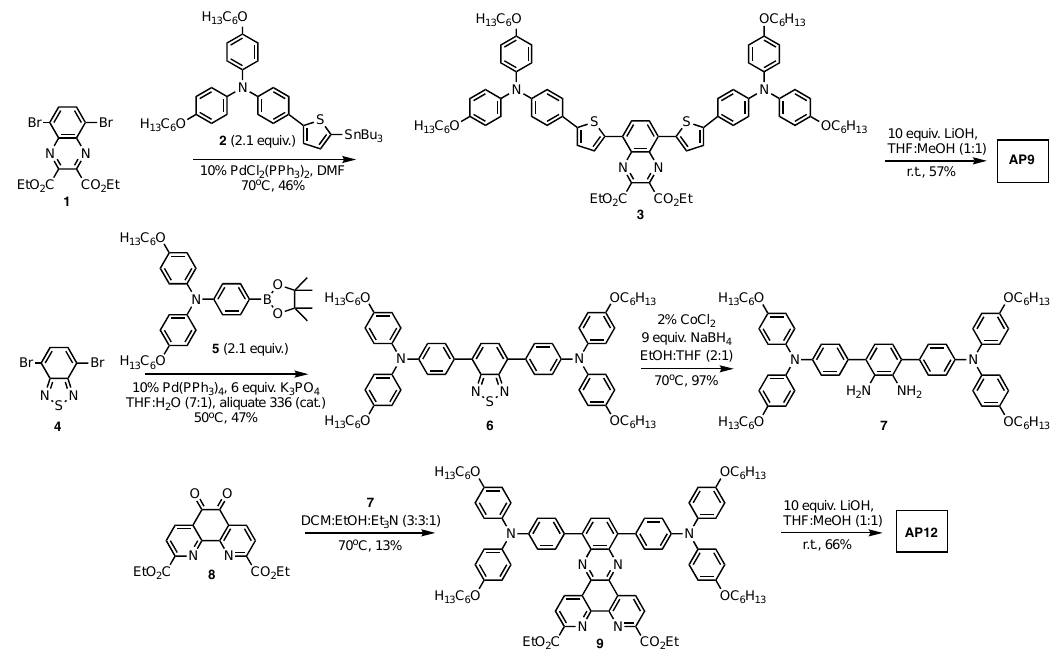
Scheme 1. Synthetic route to target dyes AP9 and AP12 .